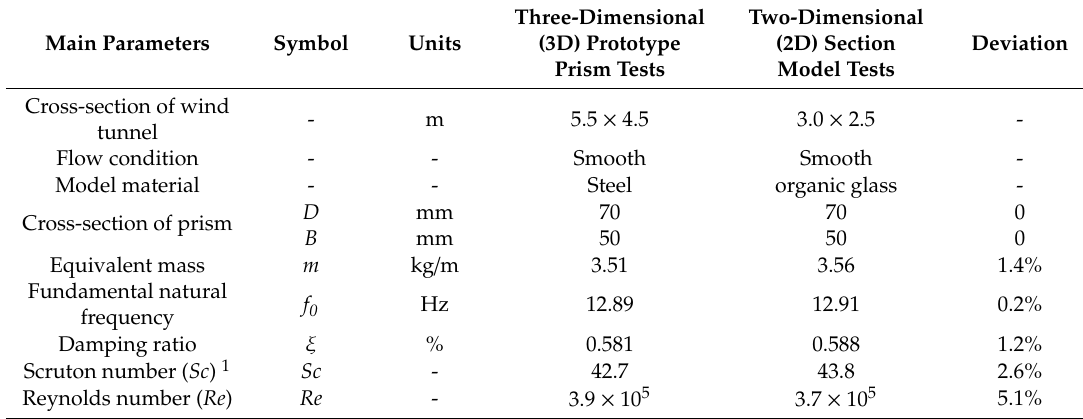
Table 1. Main model parameters.